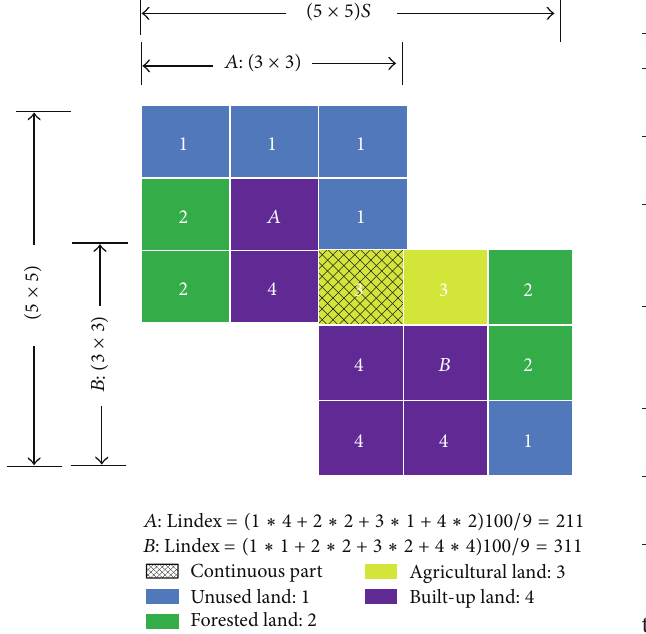
Figure 2: Spatial information of land-use intensity.